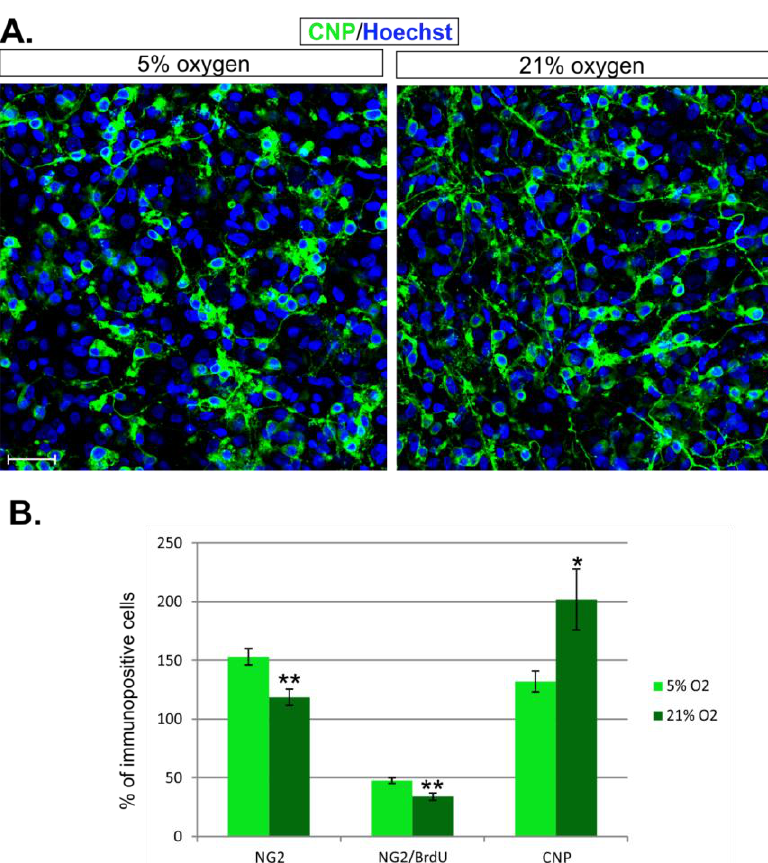
Figure 9. The influence of distinct oxygen conditions on oligodendrocyte proliferation and differentiation. ( A ) The CNP-positive oligodendrocytes ( green ) visible in hippocampal slices after 7 DIV; The cell nuclei were labelled with Hoechst 33258 ( blue ); ( B ) The diagram shows the total number of OPCs, dividing progenitors, and differentiating oligodendrocytes in hippocampal slices cultured in distinct oxygen concentrations. The scale bar is equivalent to 20 µ m. The calculated differences were regarded as statistically significant if * p < 0.05, ** p < 0.01.